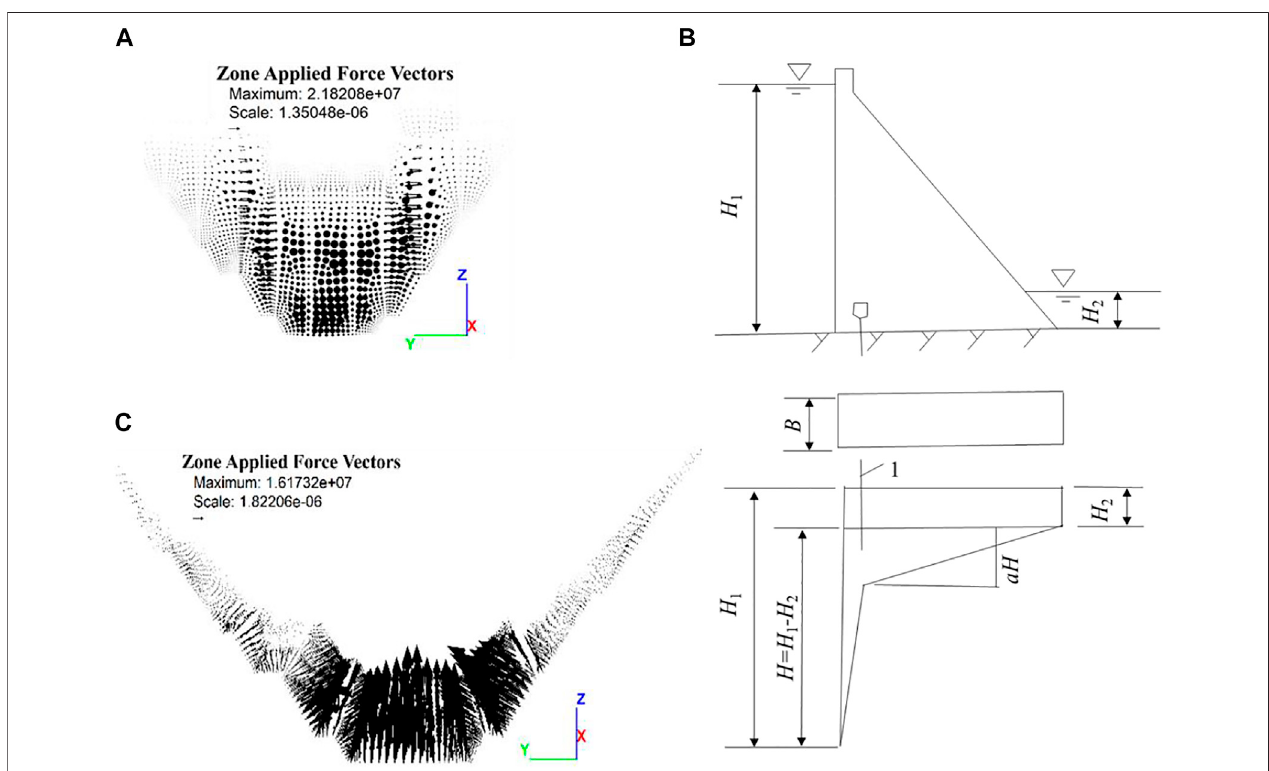
FIGURE 3 | (A) Water pressure load transformed into nodal forces applied on the upstream face of the dam. (B) An illustration for showing the calculation procedures of uplift pressure. (C) Uplift pressure load transformed into nodal forces applied on the bottom surfaces of the dam.